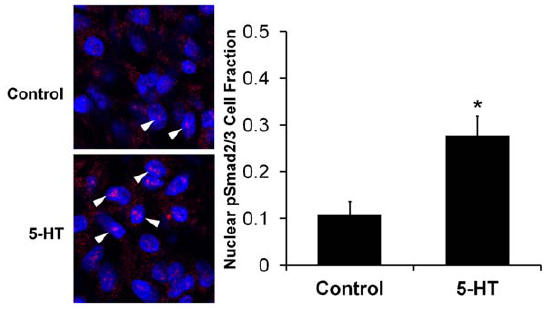
Figure 8. 5-HT increases AV cushion pSmad2/3 expression in ovo . A ) Representative images of pSmad2/3 staining. Arrows indicate pSmad2/3 positive cells. Cell nuclei – blue, pSmad2/3 – red. B ) Embryos treated with systemic 5-HT at HH17 have increased pSmad2/3 expression at HH25 indicating elevated TGF b signaling. n=6, mean 6 SEM *p , 0.01,